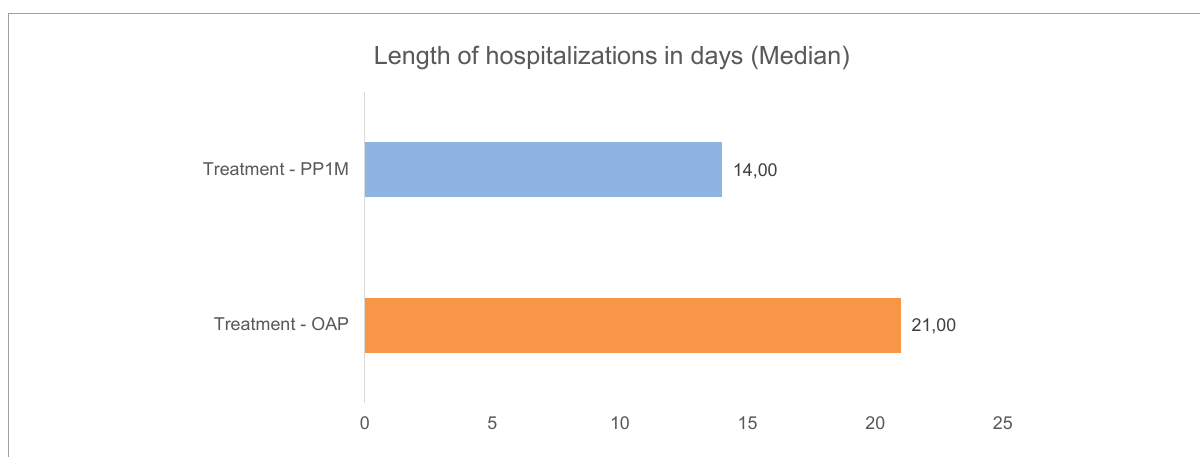
FIGURE3 Comparison between treatment conditions for a median length of hospitalizations (in days) during 12 months of